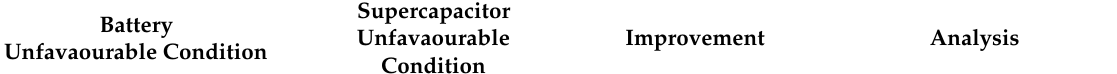
Table 7. Batteries and supercapacitors comparison on the basis of favorable and unfavorable conditions.